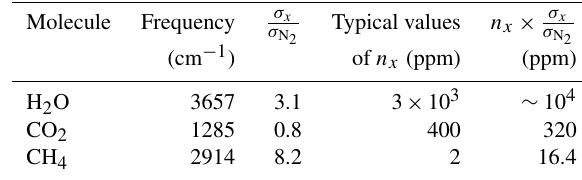
Table 1. Raman frequency shift for H 2 O, CO 2 and CH 4 molecules and their scattering cross sections normalized to the cross section of nitrogen. Results are given for an excitation wavelength of 337nm (Weber, 1979). Typical background-gas mixing ratios n x in the low are also troposphere and the product n x × σ x σ N2